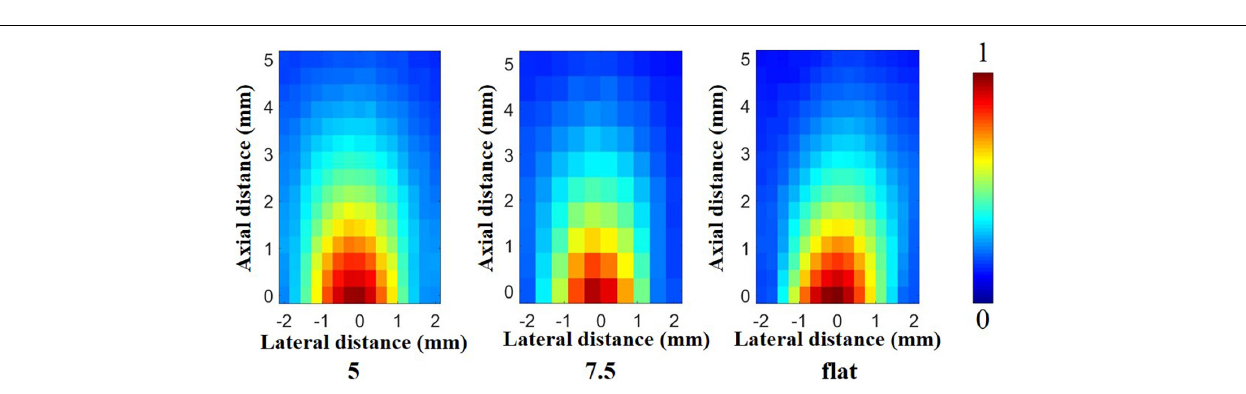
FIGURE 7 | Emission acoustic field in the